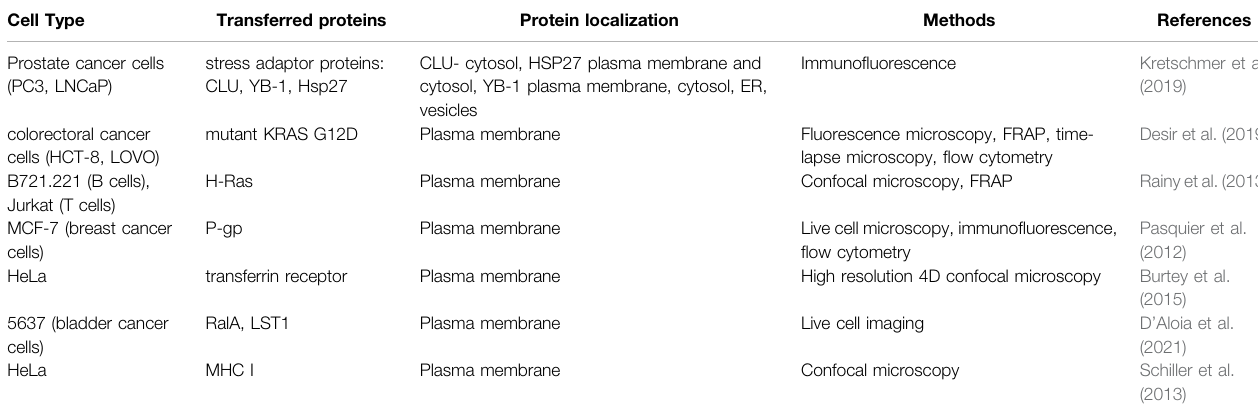
TABLE 1 | Transfer of proteins through TNTs in